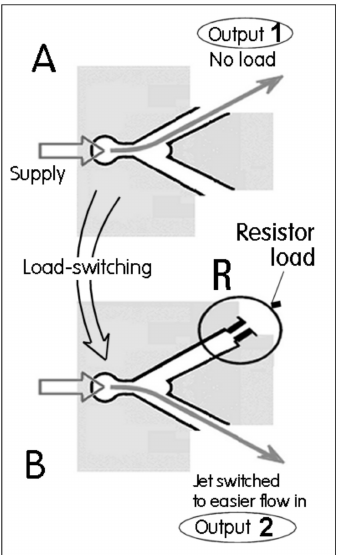
Figure 25. Oscillator [28,29] with a load-switched bistable diverter and two alternatively rotated vortex chambers, with all components in planar